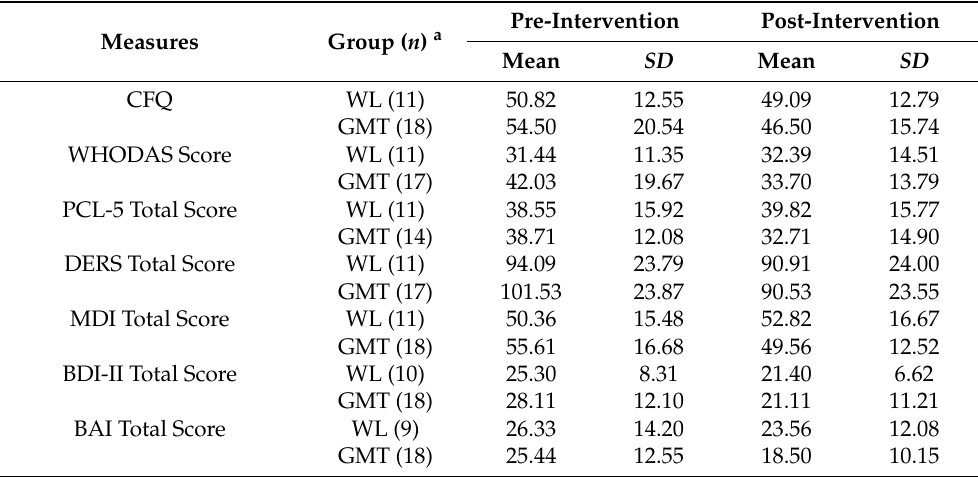
Table 4. Means and SDs for pre- and post-intervention scores for the subjective cognition, functioning, and self-report symptom measures for WL and GMT